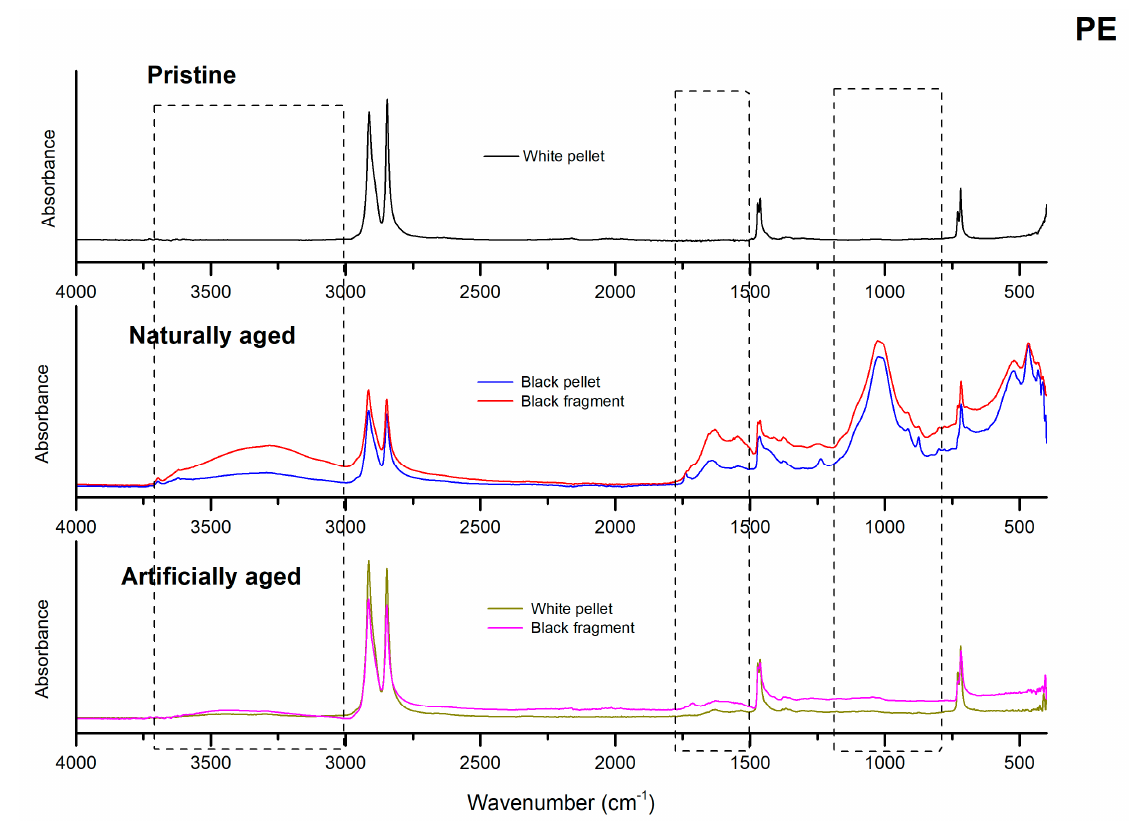
Figure 4. Comparison among the spectra of the PE pristine, artificial aged and naturally weathered particles.